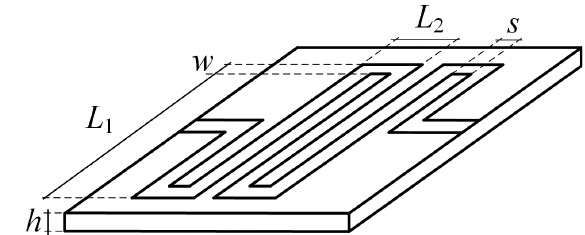
Fig. 1. Traditional meander construction where w – the width of the meander strip; s – the gap between adjacent meander conductors; L 1 – the length of the central part of meander conductor; L 2 – the length of the connecting conductors; h – the height of the